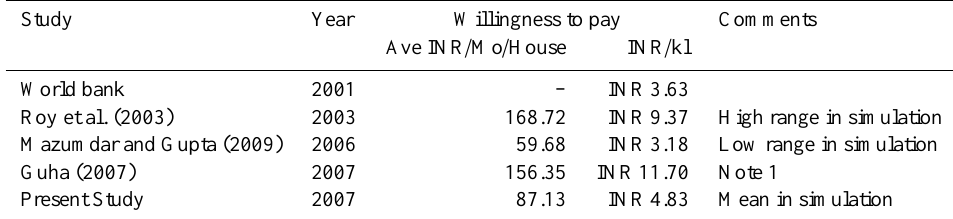
Table 5. Comparisons of WTP Studies for Water Supply in